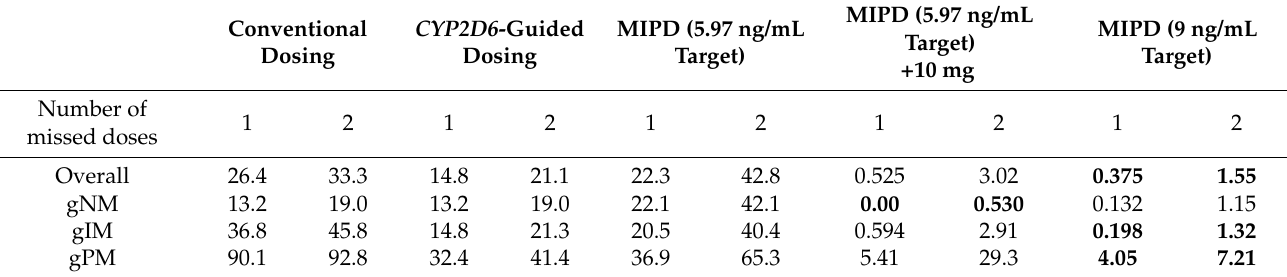
Table 2. Number of patients at risk (%) for target non-attainment due to missing